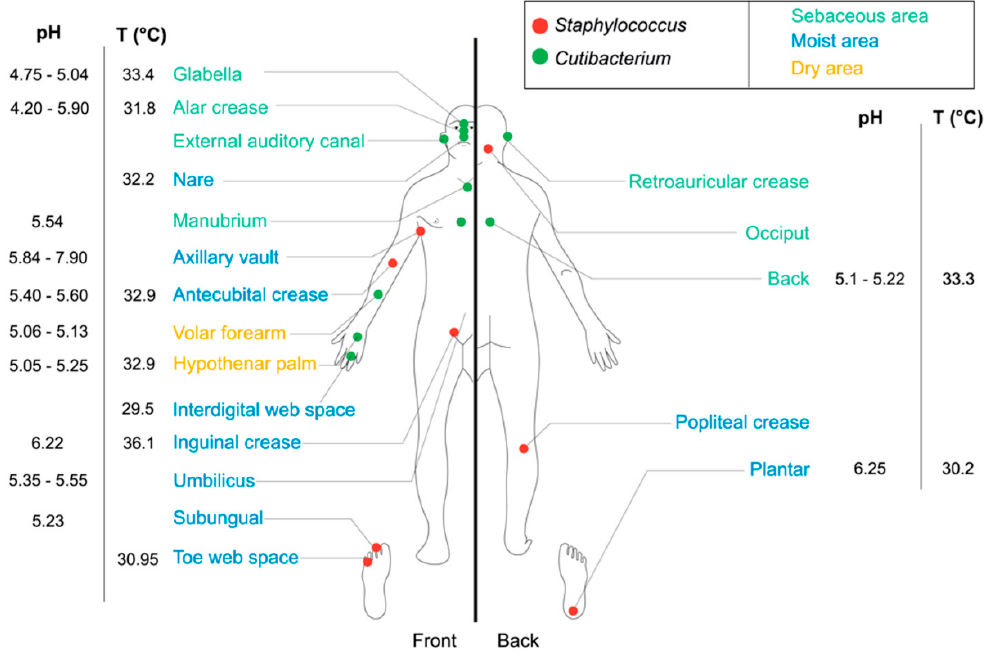
Figure 1. Topographical distribution of Staphylococcus and Cutibacterium on the human skin [22].